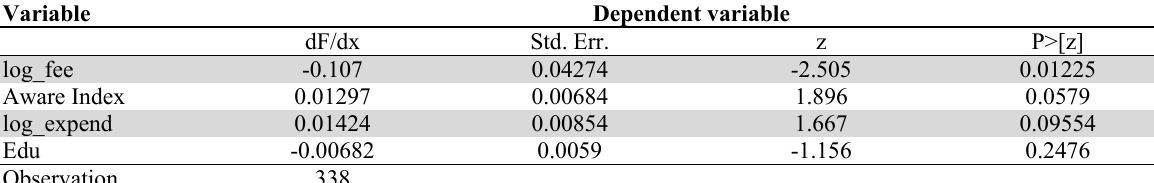
Marginal effects of connection